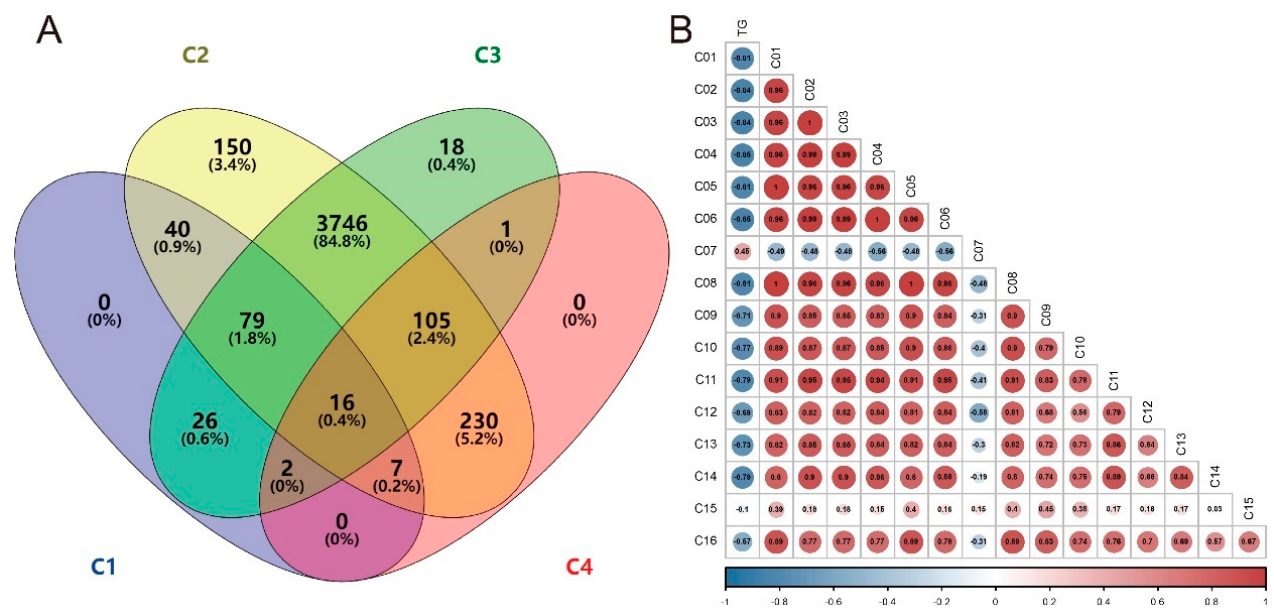
Figure 7. Venn diagram of four comparisons in differential metabolites and correlation diagram. ( A ) Venn diagram of four comparisons. C1, C2, C3, and C4 are Control_8W vs. HL_8W, Control_14W vs. Control_8W, Control_14W vs. HL_14W, and HL_14W vs. HL_8W, respectively. ( B ) Correlation analysis of TG and 16 different metabolites. Blue circles are negative correlations, while red circles are positive correlations. The number in the circle represents the correlation coefficient. A correlation coefficient >0.6 represents a positive, while a correlation coefficient < − 0.6 represents a negative.